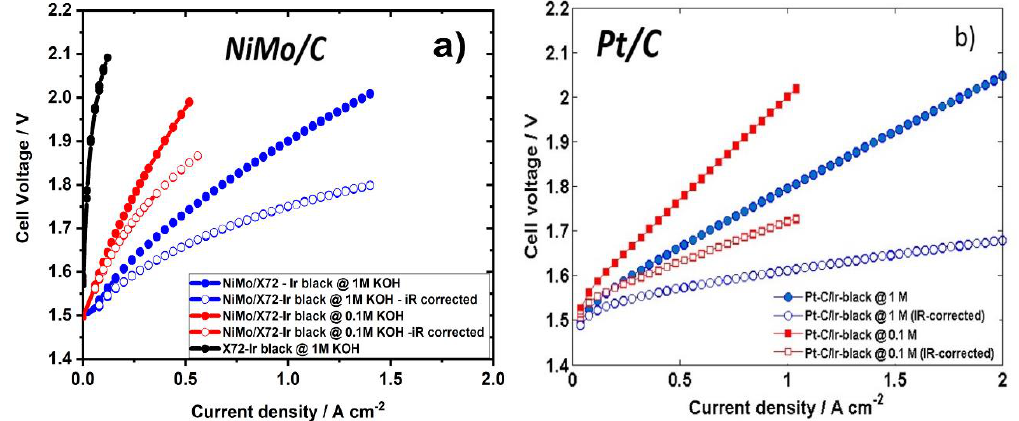
Figure 7. Polarization curves in both 1 M and 0.1 M KOH at 50 °C. ( a ) A 5 mg cm − 2 NiMo loading compared to ( b ) a 1 mg cm − 2 Pt. Cell active area: 25 cm − 2 . Both CCMs using 3 mg cm − 2 Ir-black.